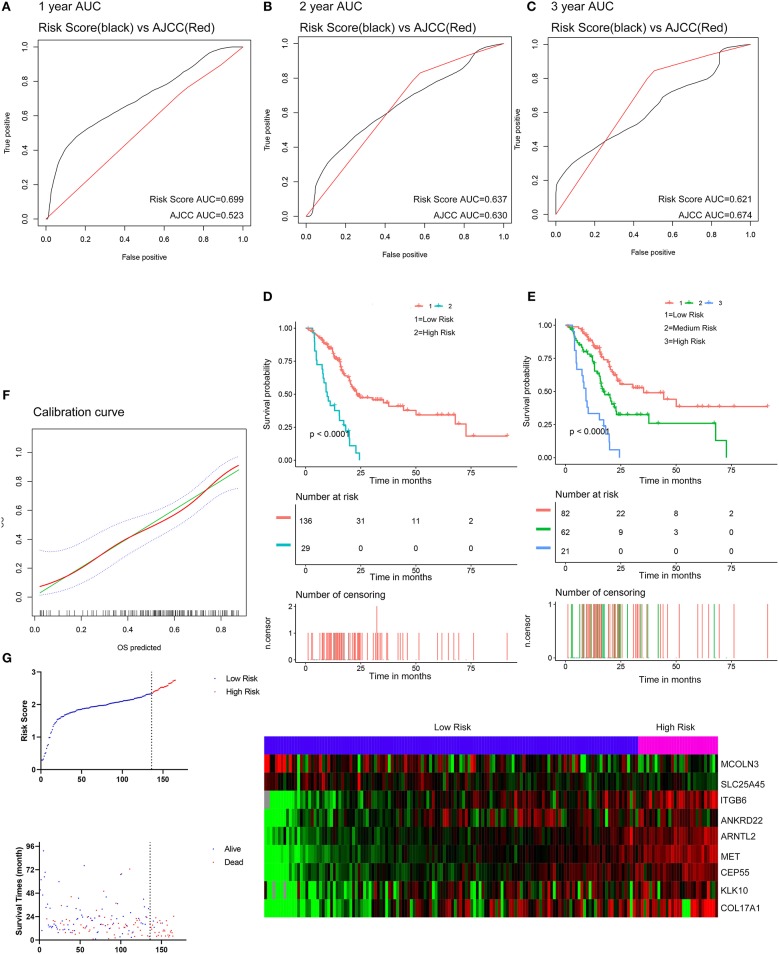
Evaluation of the performance of the nine gene signature in TCGA PAAD dataset. (A–C) Show the ROC curves for 1-, 2-, and 3-year overall survival predictions for the nine gene signature in compare with AJCC stage. (D,E) Show the Kaplan-Meier survival curves of the nine gene signature. Patients from the TCGA dataset are stratified into two or three groups according to the optimal cut-off values for the risk scores calculated by X-Tile. (F) The calibration plot for internal validation of the nine gene signature. The Y axis represents the actual overall survival while the X axis represents the predicted overall survival. (G) Distribution of the risk score, the associated survival data and the mRNA expression heat map in the TCGA dataset.